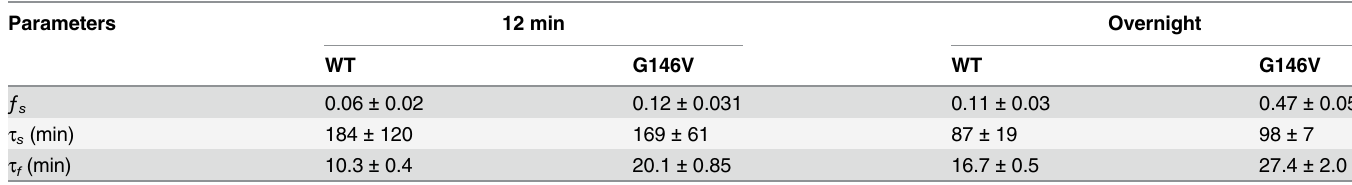
Table 1. Parameters of depolymerization.